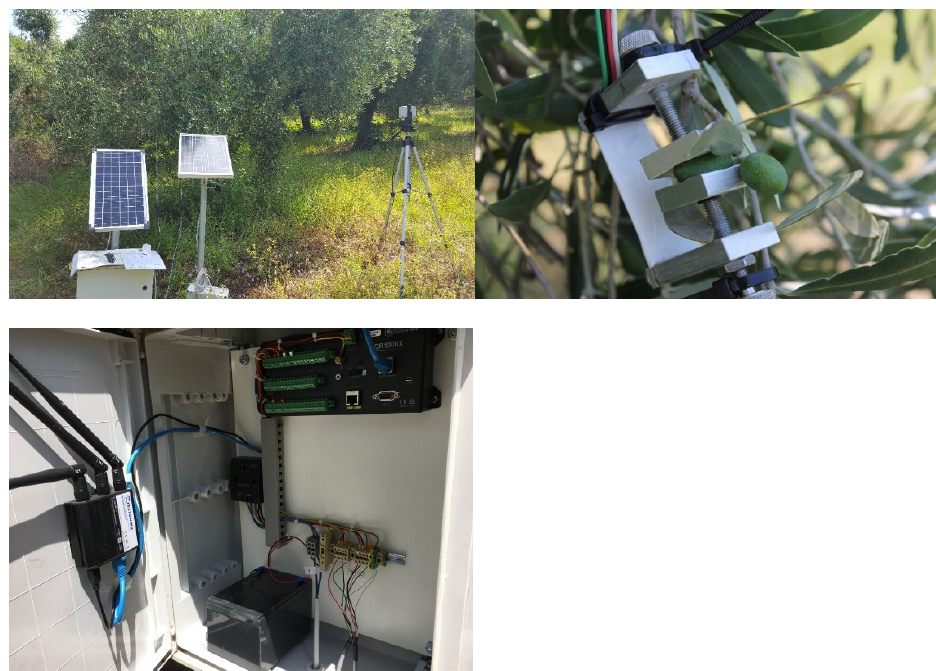
Figure 1. Olive orchard with camera and extensimeter in the olive tree powered by solar panel. Camera equipped with solar panel and AWS S3 storage(Amazon Web Services, Inc., Seattle, WA, USA) ( left – top ); highly precise DEX20 extensimeters ( right – top ); Campbell scientific data logger CR1000X inside the metal box of data logger ( left – down ).